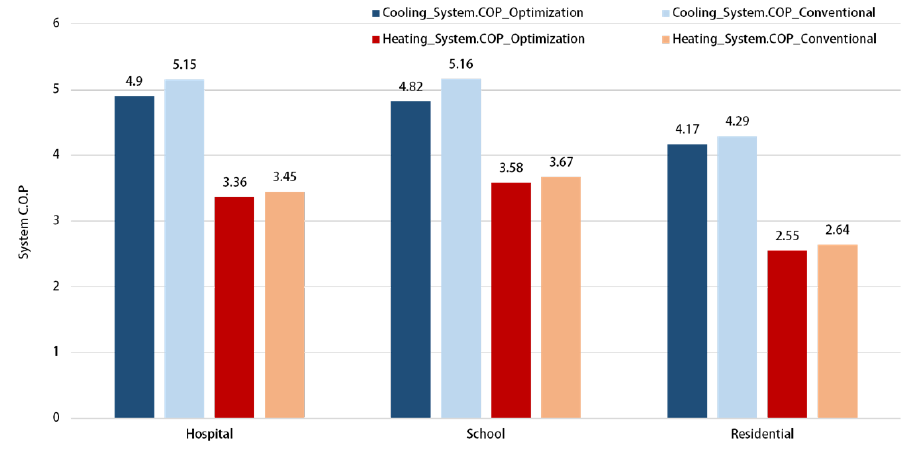
Figure 17. Comparison of system COP according to the optimization results by building type.